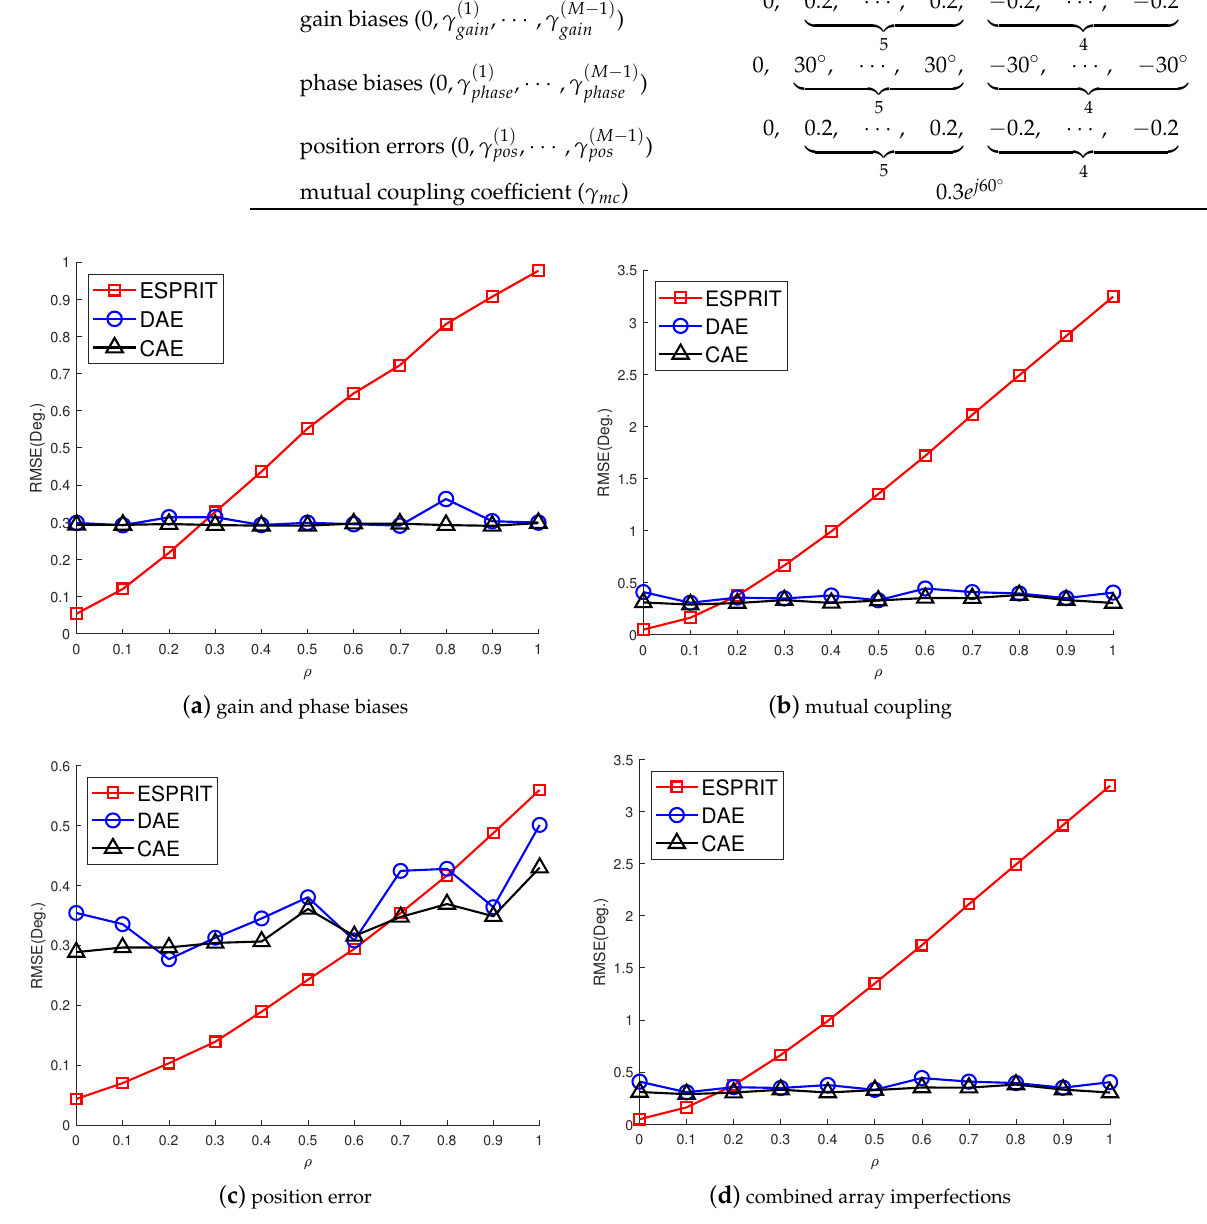
Figure 10. RMSE performance of DOA estimation for ESPRIT, DAE, and CAE methods with different array imperfections versus the imperfection control parameter ρ at 10 dB SNR: ( a ) antenna gain and phase biases, ( b ) antenna mutual coupling, ( c ) antenna position error, ( d ) combined array